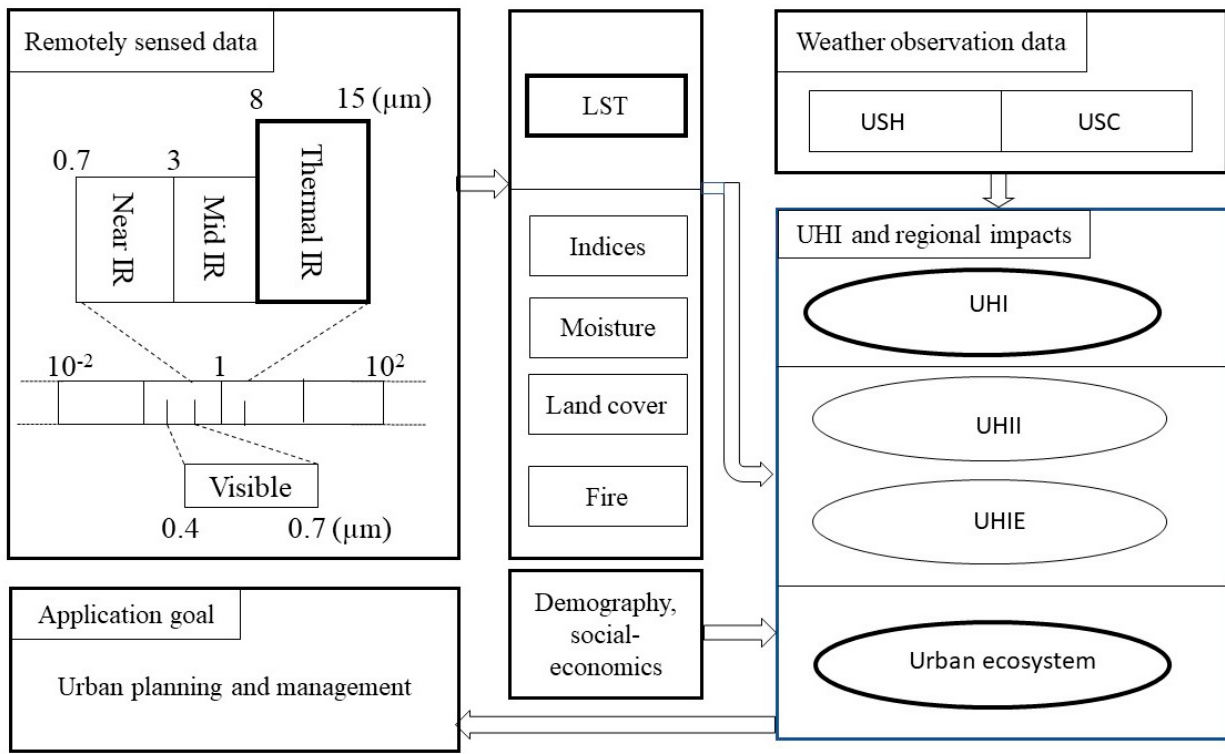
Figure 2. Schematic diagram for using remotely sensed data to evaluate UHI and UHIRIP. Bold outlines indicate high importance. USH—US historical weather data; USC—US climate data; UHI—urban heat island; UHII—UHI intensity; UHIE—UHI effects; IR—infrared band.